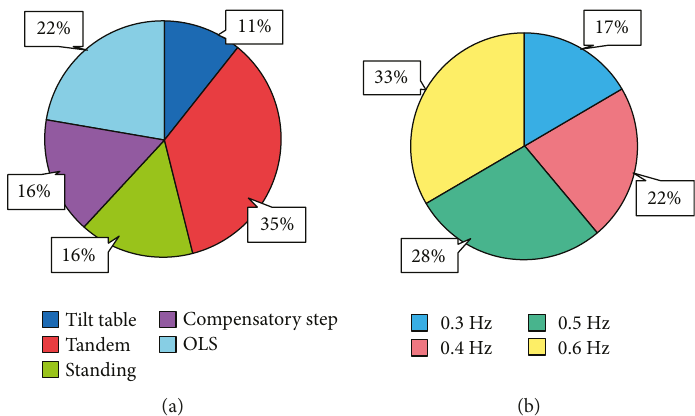
Figure 1: (a) Distribution of the exercise subtypes in % of the total duration of the balance training sessions. The data originate from of all patients and all sessions collapsed. OLS: one leg stance. (b) Distribution of the platform perturbation subtypes in % of the total duration of the platform training sessions, all patients, and all sessions collapsed. Each patient was trained with from easy to di ffi cult